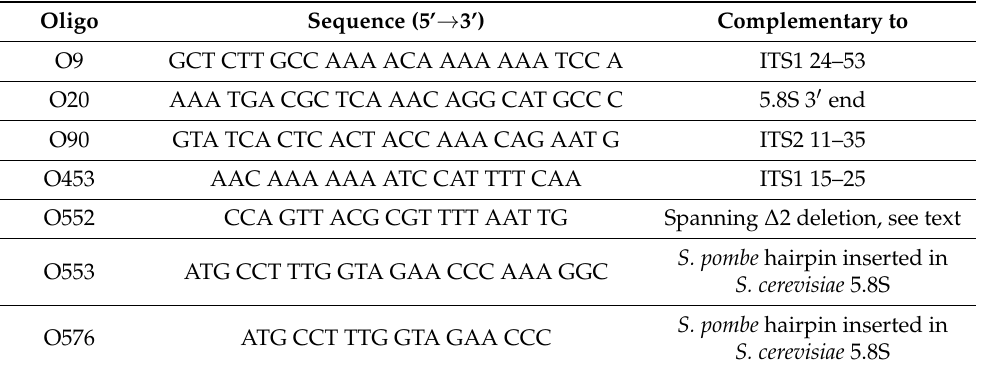
Table 1. Sequence of oligonucleotides used.